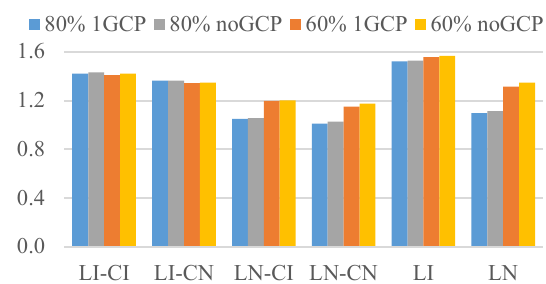
Figure 3 . Average standard deviation of Z differences in GSD units for the six configurations in the GNSS